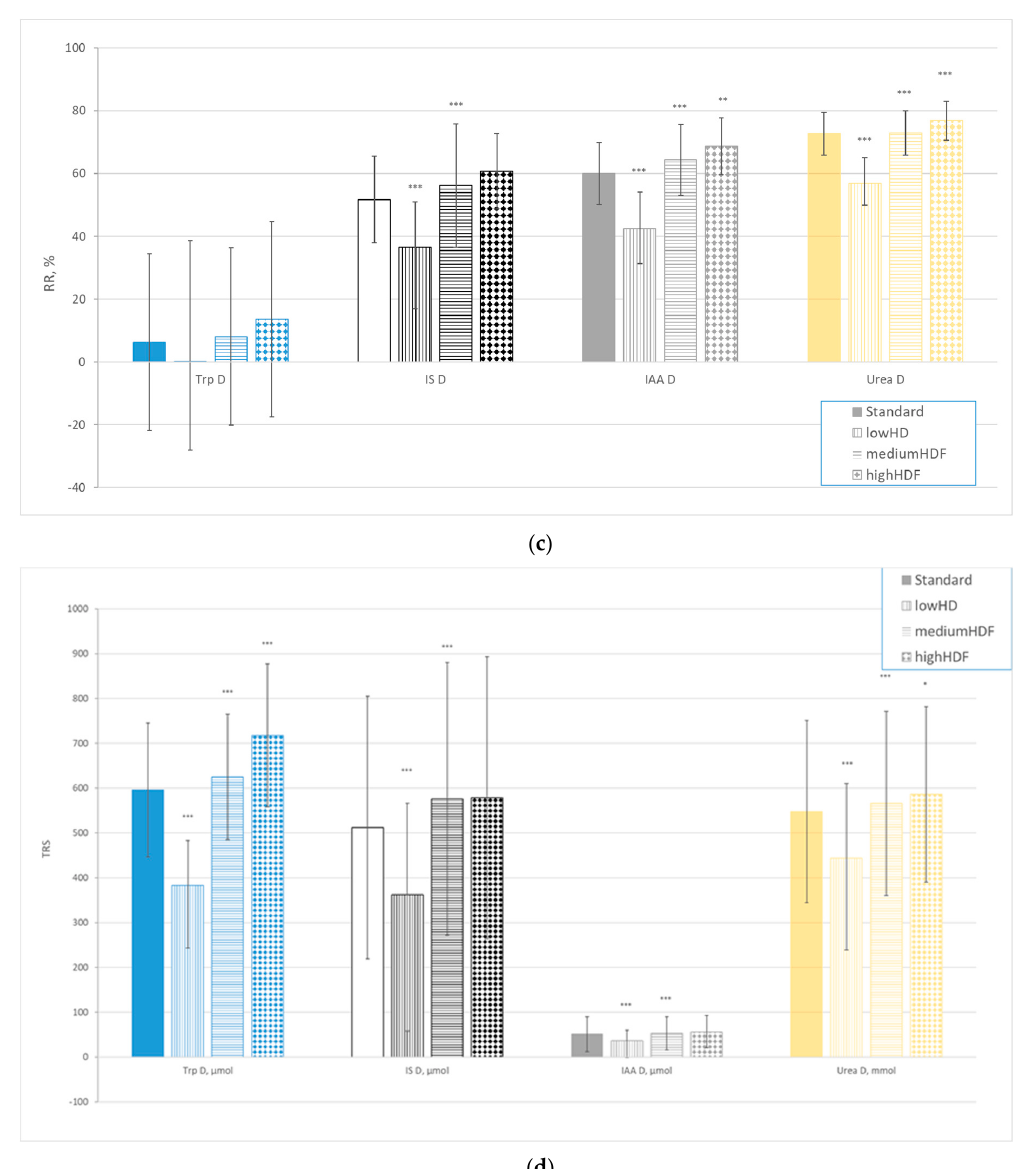
Figure 4. Reduction ratios (RR) and total removal of solute (TRS) calculated for urea, Trp, IS and IAA from the start and end (240 min) of the dialysis session for different dialysis modalities and settings: ( a ) RRs assessed from total serum concentrations ( n = 77); ( b ) RRs assessed from free serum concentrations ( n = 77); ( c ) RRs assessed from spent dialysate concentrations ( n = 53); and ( d ) TRS of urea (in mmol), Trp, IS and IAA (in µmol) ( n = 74). *** p < 0.001; ** p < 0.01; * p < 0.05 vs. previous modality value.